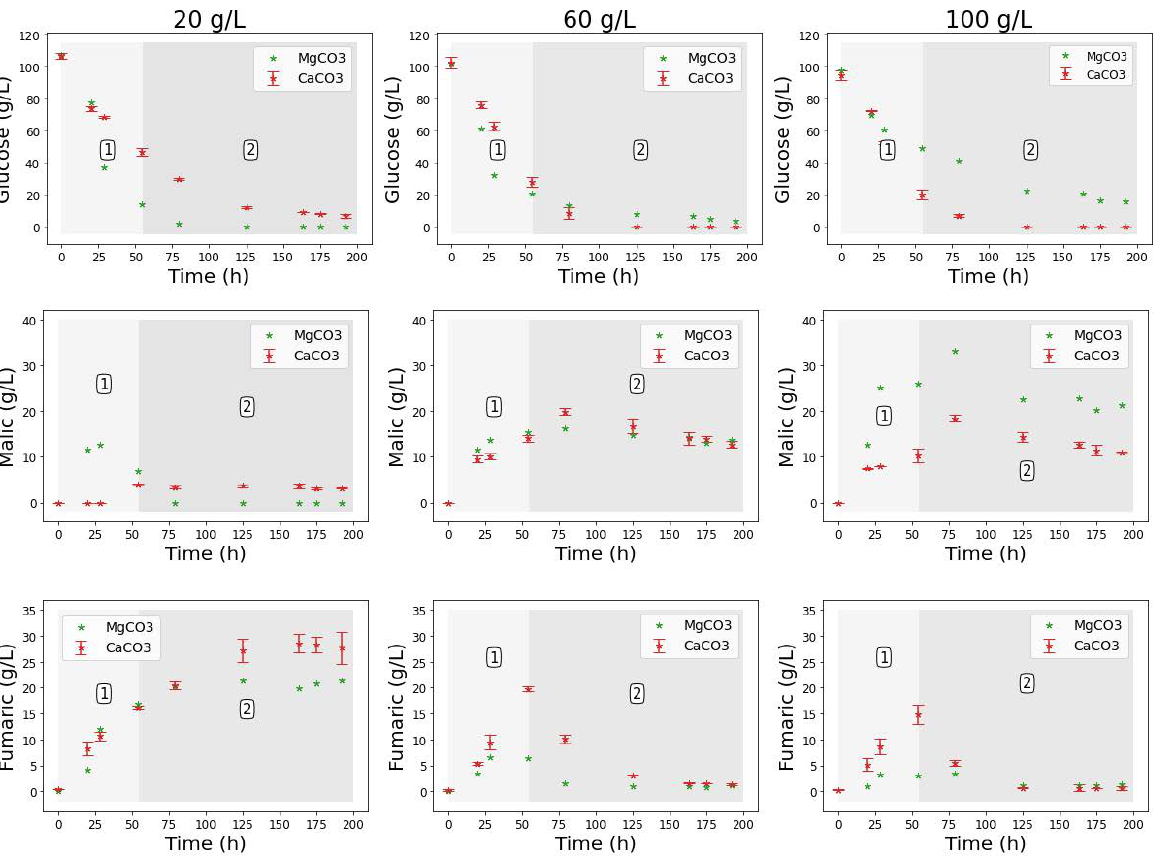
Figure 3. Comparison between the glucose, FA, and MA profiles in shake flask cultivations with CaCO 3 and MgCO 3 concentrations varied between 20 and 100 g L − 1 . Regimes 1 and 2 indicate the co-production and fumarate depletion phases,